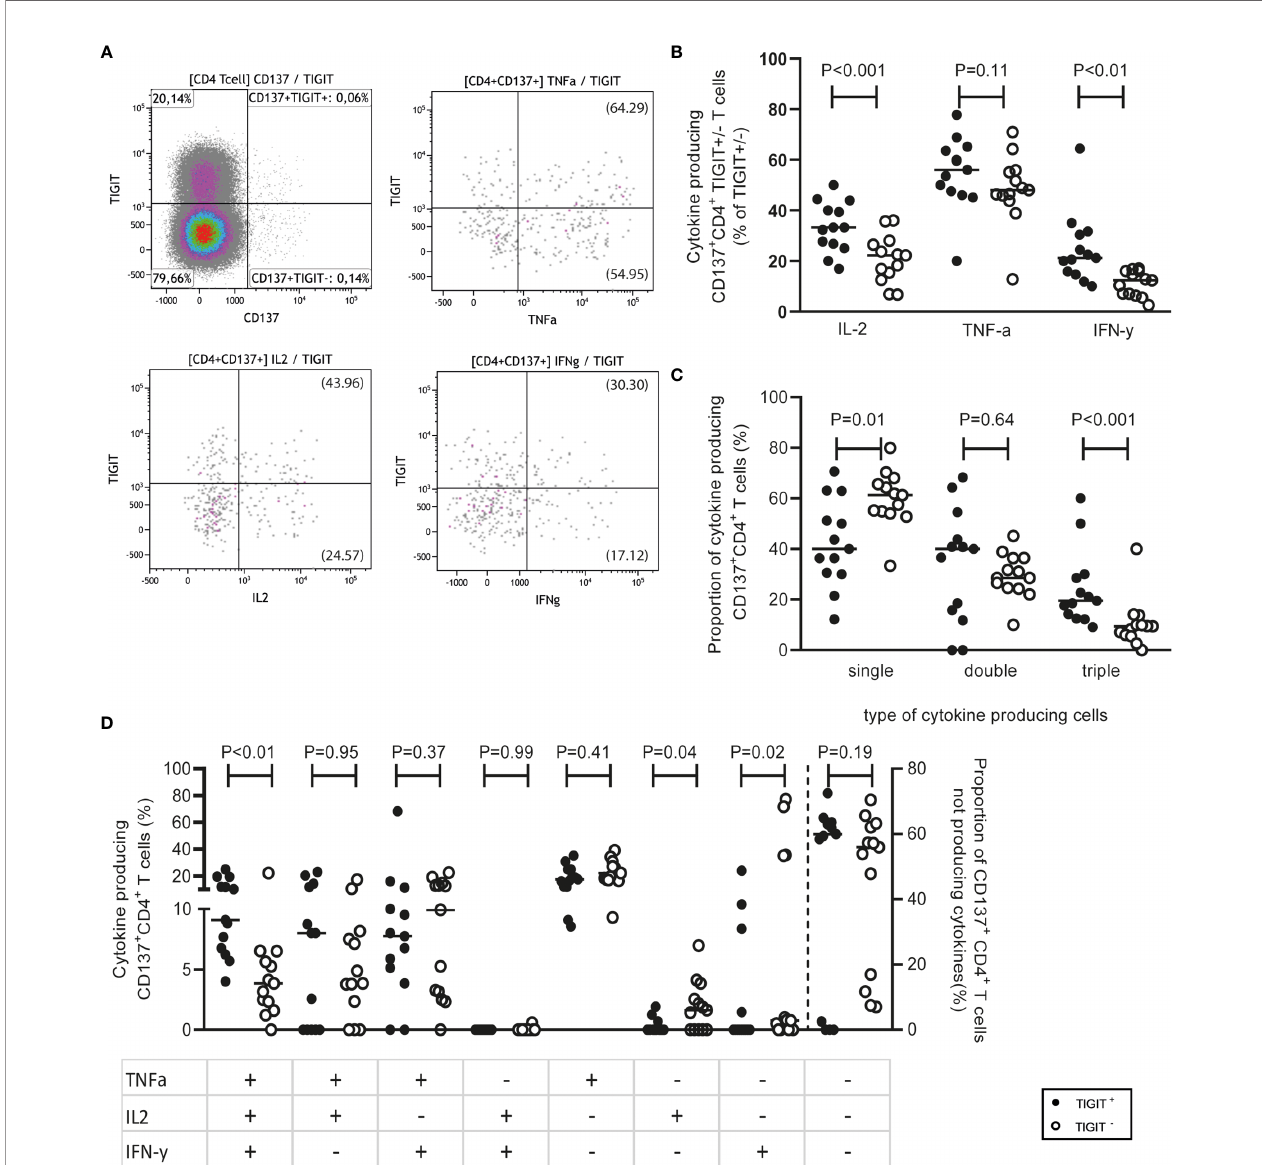
FIGURE 5 | CD4+CD137+ TIGIT+ T cells secrete cytokines in a polyfunctional manner. (A) PBMCs obtained from 13 responders (4 healthy individuals and 9 kidney transplant recipients pre transplantation) following stimulation with alloantigen. A representative sample illustrates how CD4+CD137+ T cells were gated then analyzed for co-expression of TIGIT and the cytokines, TNF- a , IL-2 and IFN- g . In brackets is shown the fraction of TIGIT+/- within CD137+CD4+ T cells which express the cytokine. (B) The percentage of cytokine-producing CD4+CD137+ T cells either positive or negative for TIGIT which produce IL-2, TNF- a and/or IFN- g . (C) The proportion of cytokine producing CD4+CD137+ T cells within the TIGIT positive or negative portions which produce one (single), two (double) or all (triple) of the cytokines, TNF- a , IL-2 and IFN- g . (D) The combinations of TNF- a , IL-2 and IFN- g cytokines produced by CD4+CD137+ T cells divided according to TIGIT